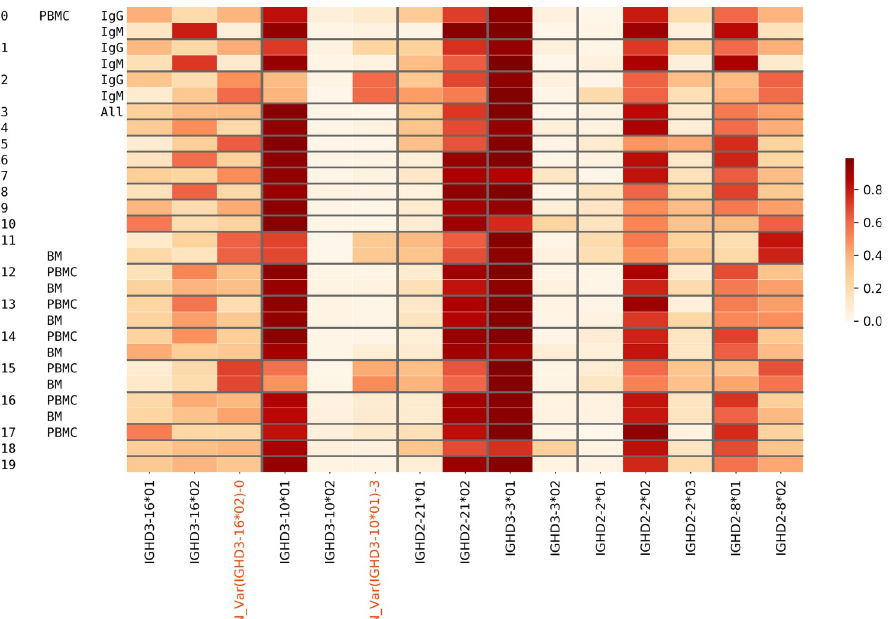
Fig 5. Usage of variants of D genes in Healthy PBMC BM datasets. Gray lines separate the plot such that each subplot corresponds to one gene and its variants. Each cell in a subplot represents the proportion of the usage of a variant with respect to the total usage of all variants. Thus, in every subplot, the sum of all rows is 1. The columns on the y-axis tick labels represent the individual, the tissue, and the isotype, respectively.